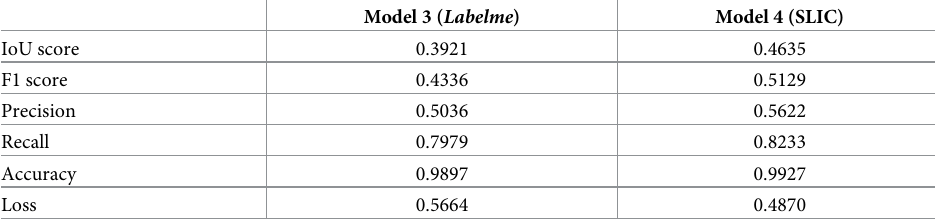
Table 2. Tissue classification from models with different labeling